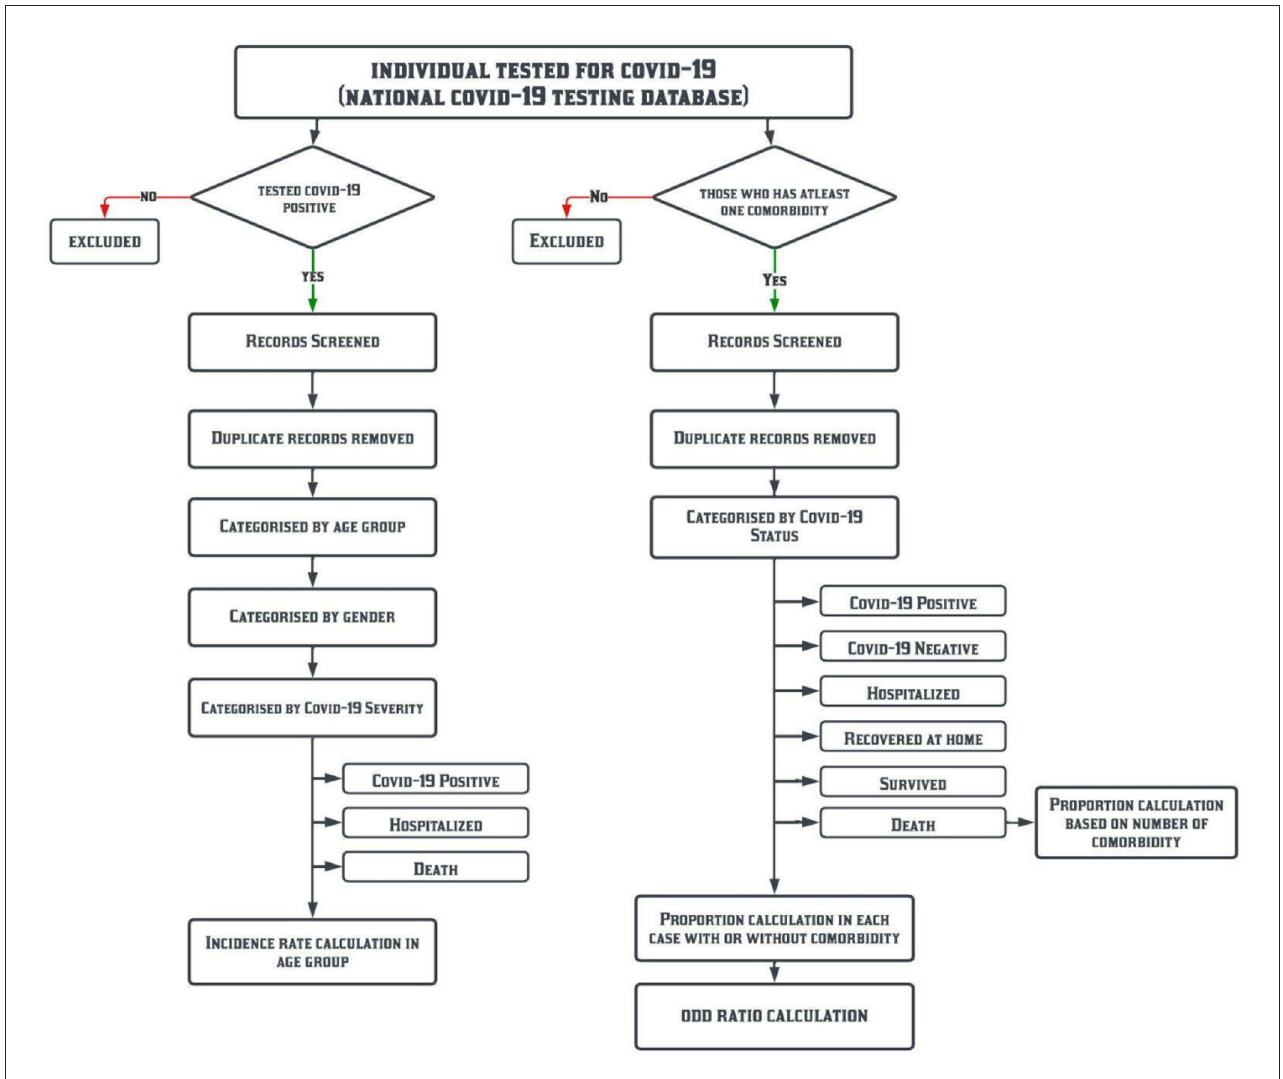
FIGURE1 Data analysis work